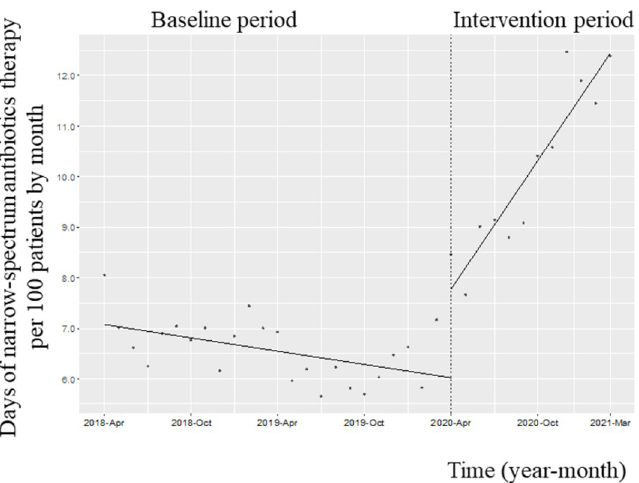
Fig 3. Trends in the days of narrow-spectrum antibiotic (ampicillin, ampicillin–sulbactam, cefazolin, and cefmetazole) therapy per 100 patients, by month, during Phase 2 of the intervention period. Each dot refers to the days of narrow-spectrum antibiotic therapy per 100 patients in each month, and the slope is based on linear regression in the two phases. The explanation of each phase is as follows: Phase 1 (antimicrobial notification by the infection control team from April 1, 2018, to March 31, 2020); Phase 2 (establishing an infectious disease [ID] consultation service and implementation of the Antimicrobial Stewardship Program [ASP] from April 1, 2020, to March 31, 2021). The trend in the monthly DOT of the four narrow-spectrum antibiotics increased (coefficient: 0.47; 95% confidence interval [CI]: 0.37 to 0.57, p < 0.001), and its level increased (coefficient: 1.76; 95% CI: 1.00 to 2.53, p < 0.001).